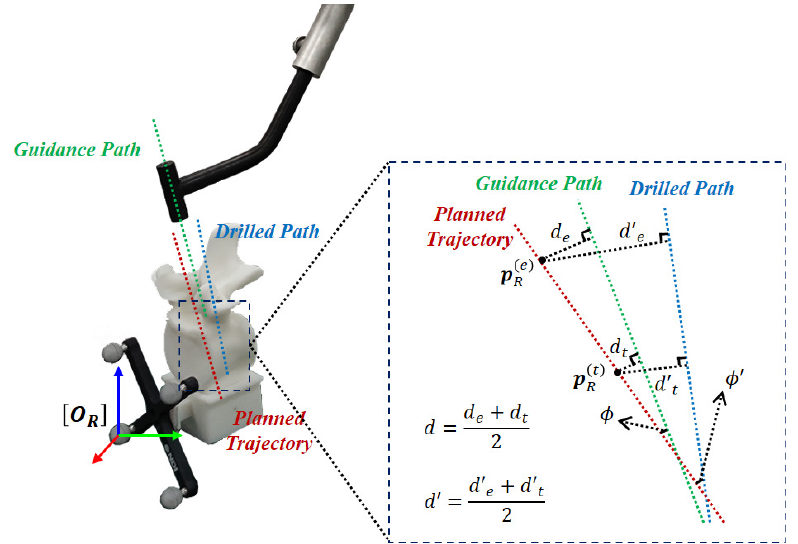
Figure 6. Metrics used to evaluate the accuracy in this study, including distance deviation d and d (cid:48) , as well as incline angle φ and φ (cid:48)